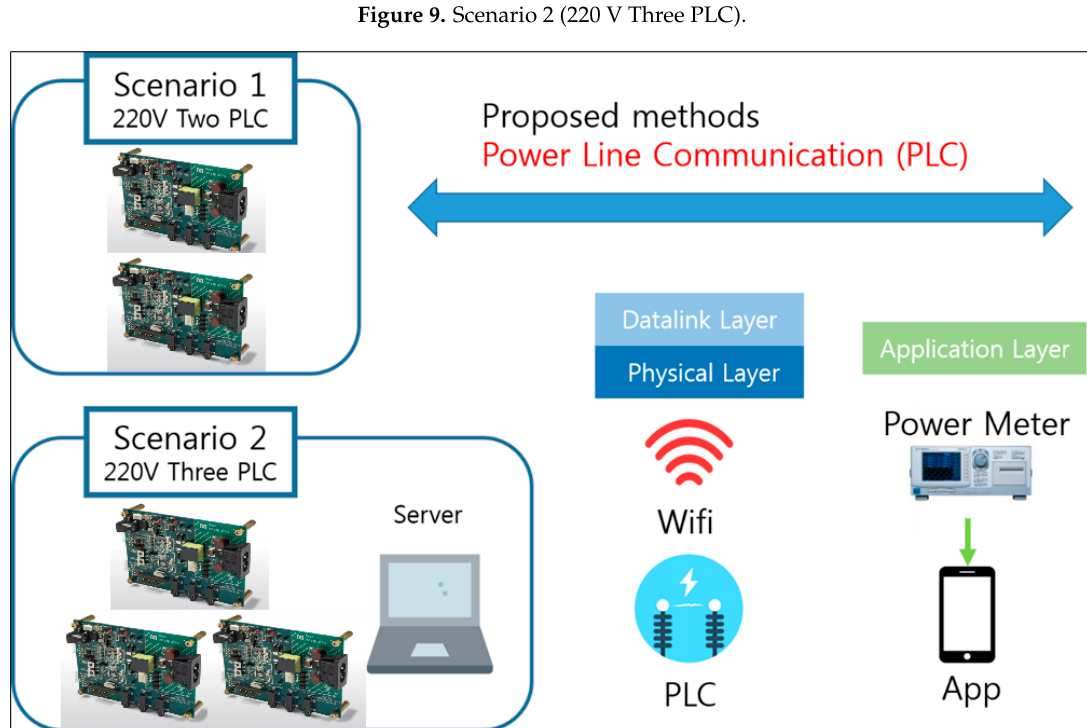
Figure 10. A Framework for Single-Living Senior Citizens Care System.